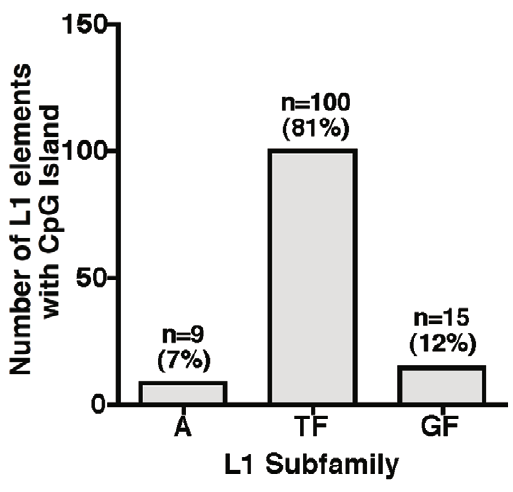
Figure 8. Distribution of CpG islands among the mouse L1s subfamilies (n=124 L1 promoters).